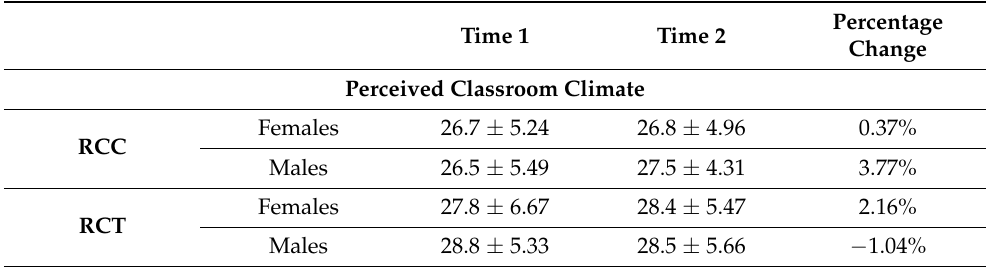
Table 6. Differences in perceived classroom climate in Time 1 (before lockdown declaration) and Time 2 (after lockdown) based on